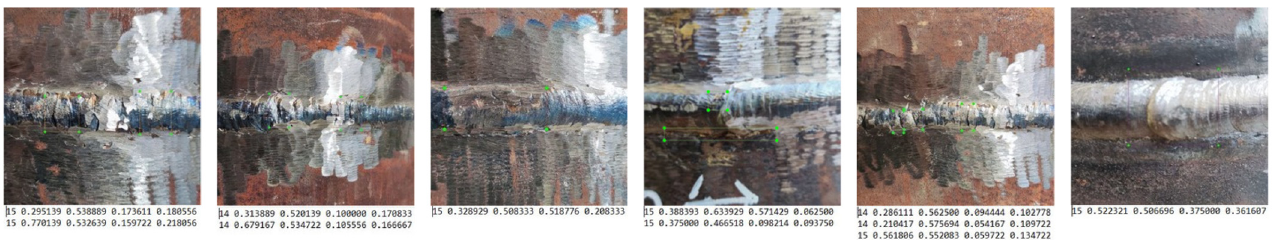
Figure 5. Samples of marked welds in steel pipelines